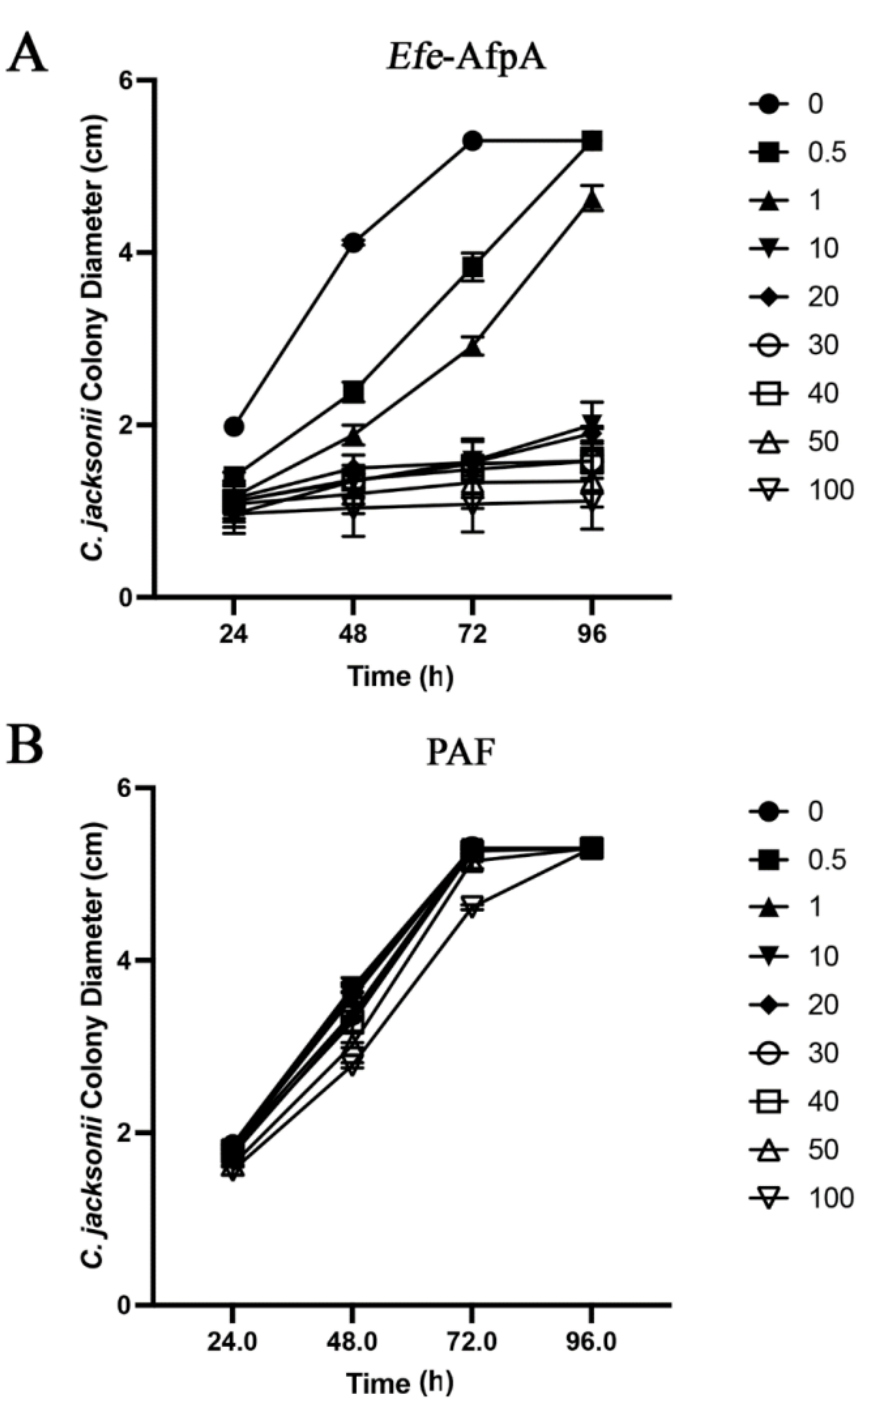
Figure 6. Effect of Efe -AfpA ( A ) or PAF ( B ) on C. jacksonii mycelial growth. C. jacksonii mycelial plugs were subcultured onto PDA plates amended with increasing concentrations of either Efe -AfpA or PAF. The colony diameters were measured daily. The data presented are the means and standard deviations of three replicates. Photographs of the plates are shown in Figures S2 and S3.